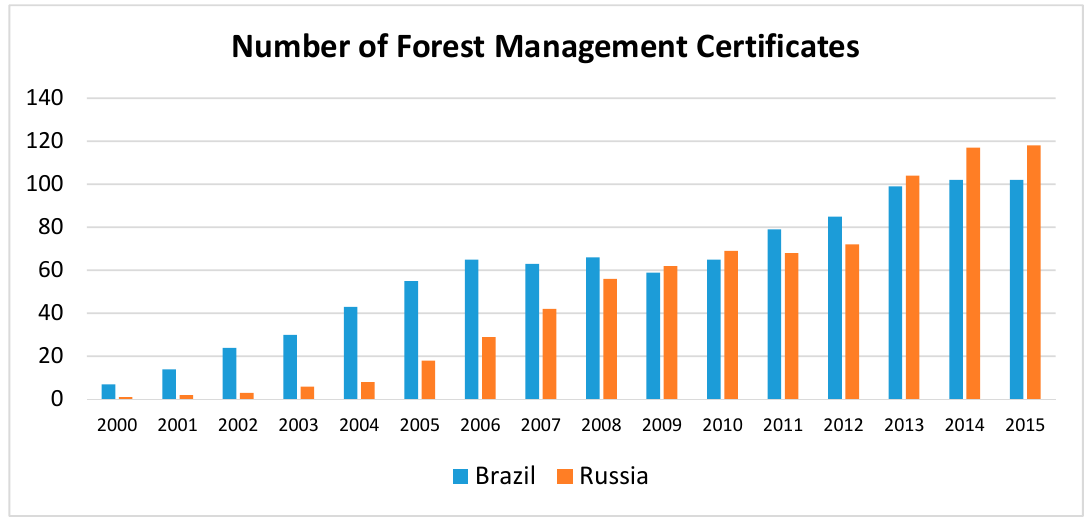
Figure 3. Number of FSC forest management certificates granted in Brazil and Russia, 2000–2015. Source: FSC International.